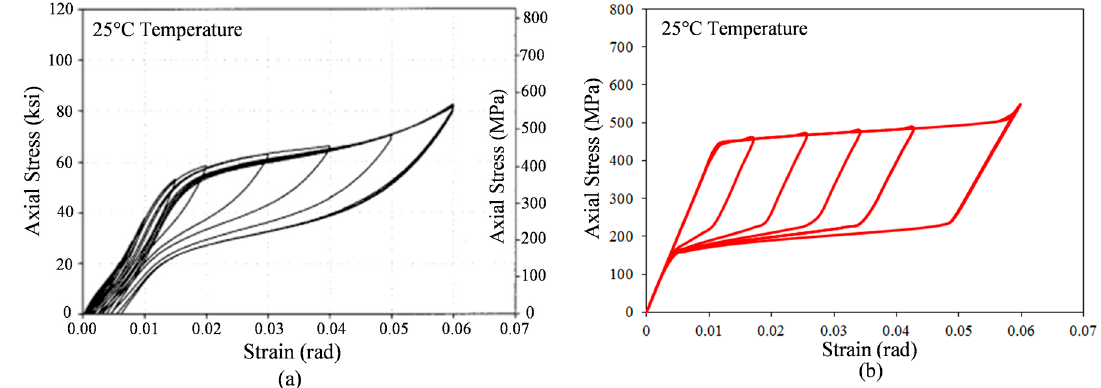
Figure 10. Material properties of SMA materials: ( a ) Experimental curve; ( b ) simulated curve.